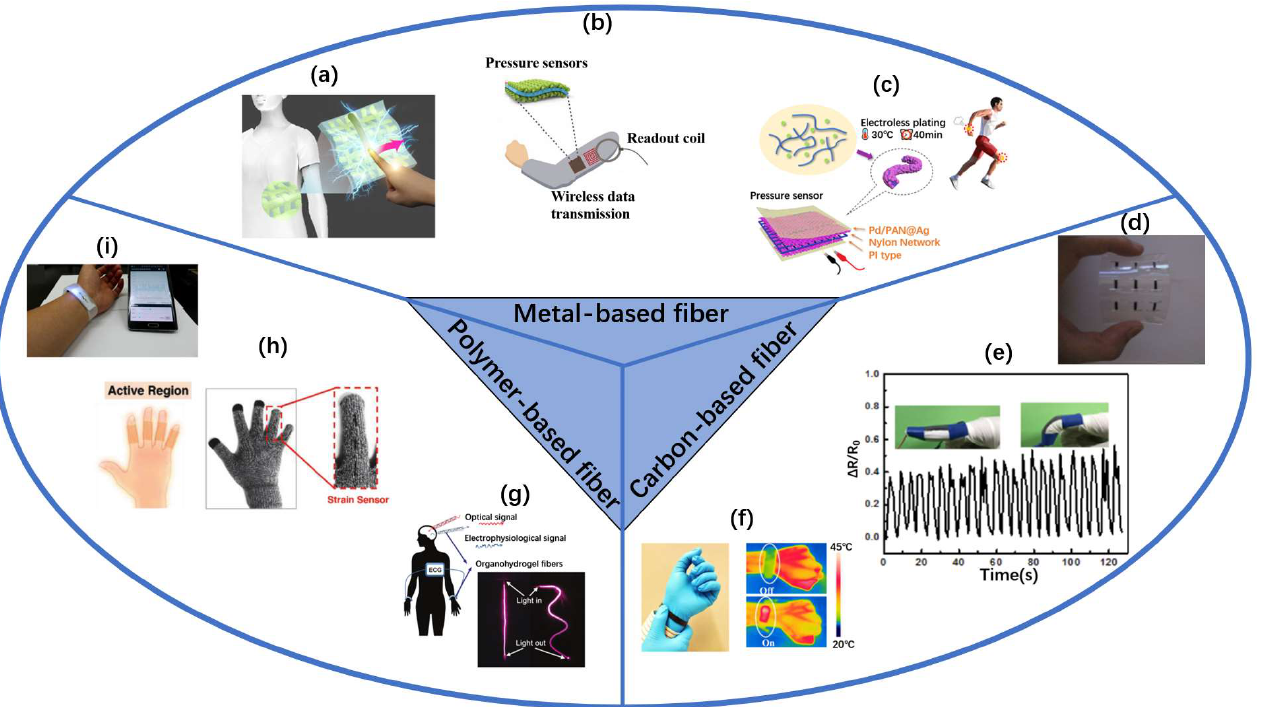
Figure 1. Various wearable sensors prepared from three types of conductive fibers used to detect various parameters of the human body: ( a ) capacitive sensors used in clothing [21], ( b ) an all-fabric pressure sensor with a wireless battery-free monitoring system [22], ( c ) piezoresistive sensor for monitoring human movement[23], ( d ) 3 × 3 flexible strain sensing array[24], ( e ) strain sensor monitors human movement[25], ( f ) a sensor that can be heated and monitored[26], ( g ) smart wireless blood pressure sensor[10], ( h ) a strain sensor applied to gloves[27], ( i ) capacitive sensor made into keyboard [28].